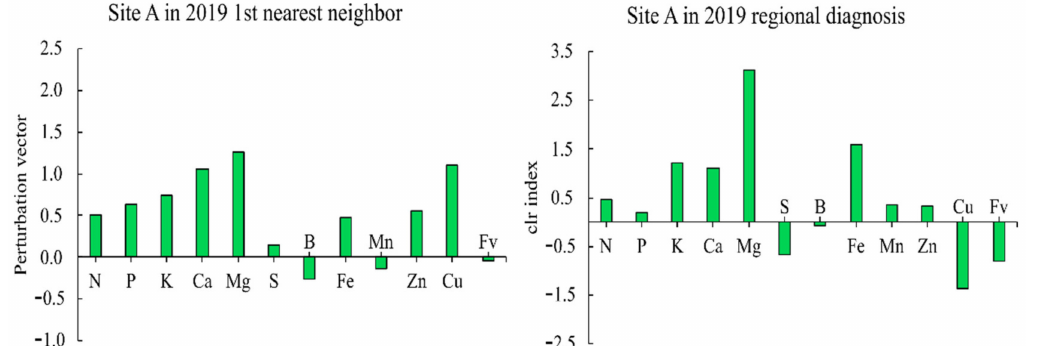
Figure 4. Nutrient diagnosis at local scale at site A in 2019 slightly differed from nutrient diagnosis at the regional scale. The difference in Cu diagnosis is attributable to the time and rate of fungicide applications. Fv = filling value. Negative differences between defective and successful specimens indicate relative shortage. Positive differences indicate relative